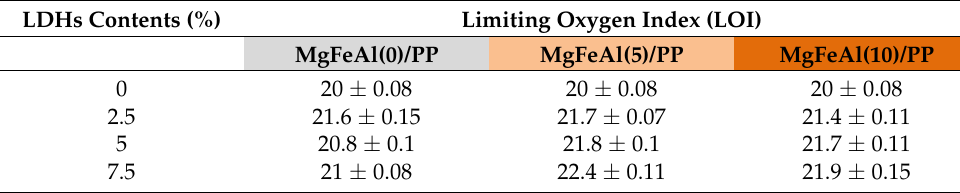
Table 3. Limiting oxygen index (LOI) of different LDH/PP nanocomposites.